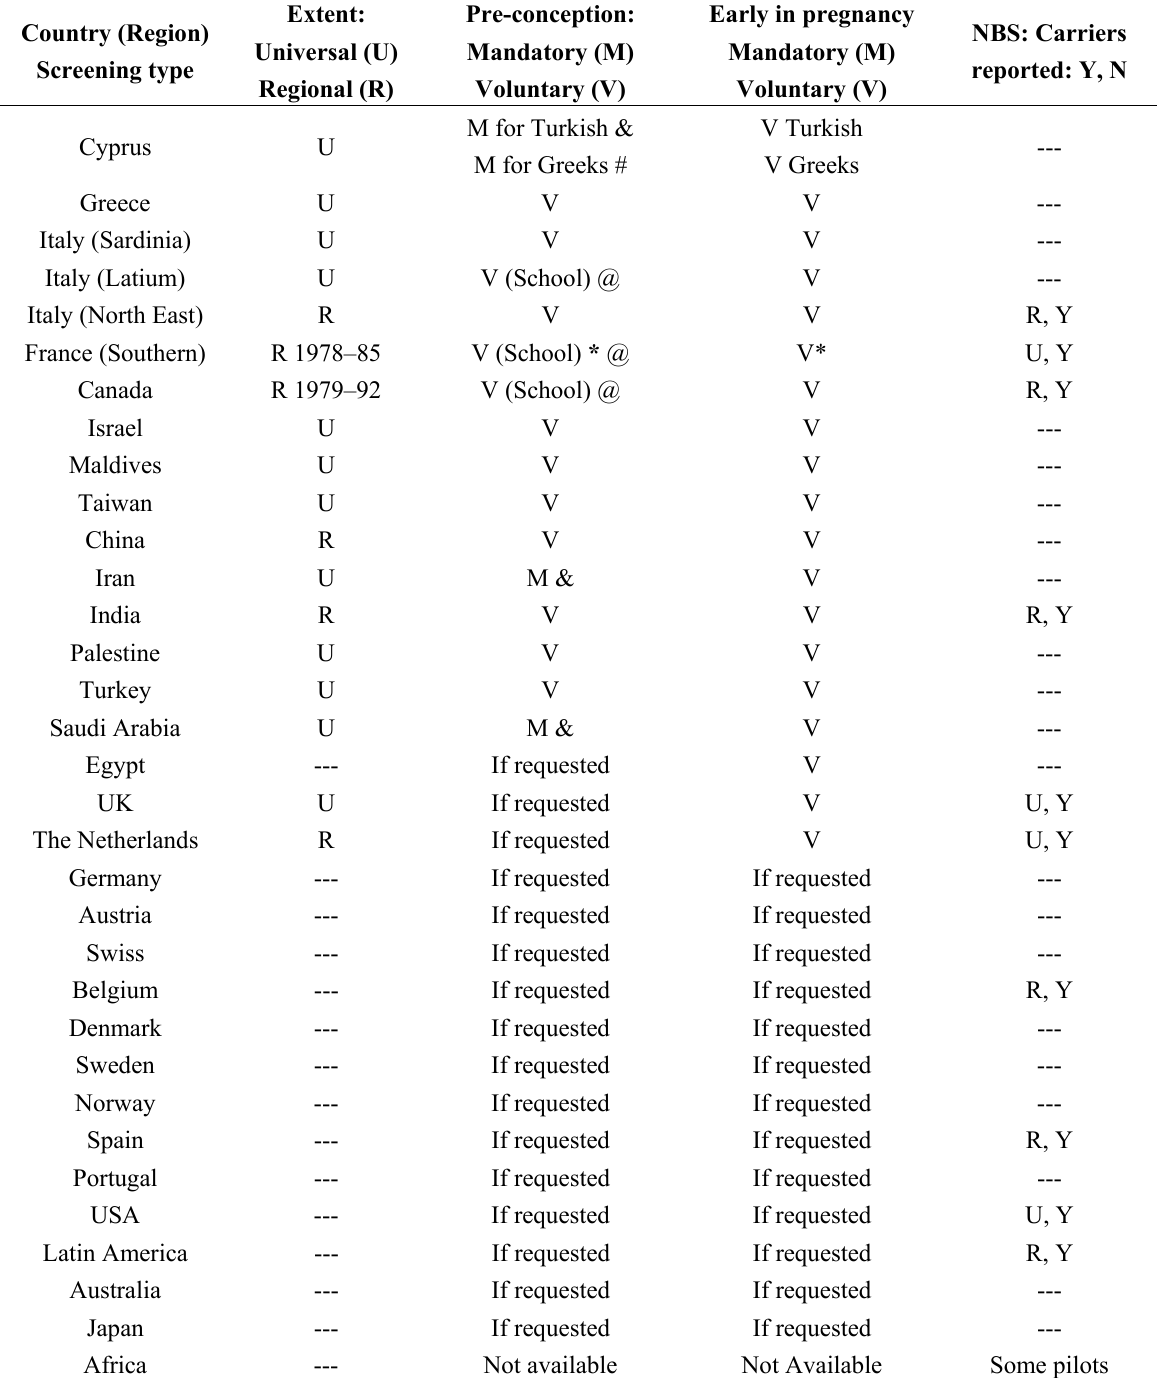
Table 1. Global preventive carrier screening for Hemoglobinopathy before conception or early in pregnancy and newborn screening reporting carriers, today. Countries with longest experienced at the top. NBS= Newborn screening; * School and pregnancy screening interrupted in 1986 and 1995 respectively. # Mandatory before Church marriage only. & Mandatory before marriage. @ At secondary or high school